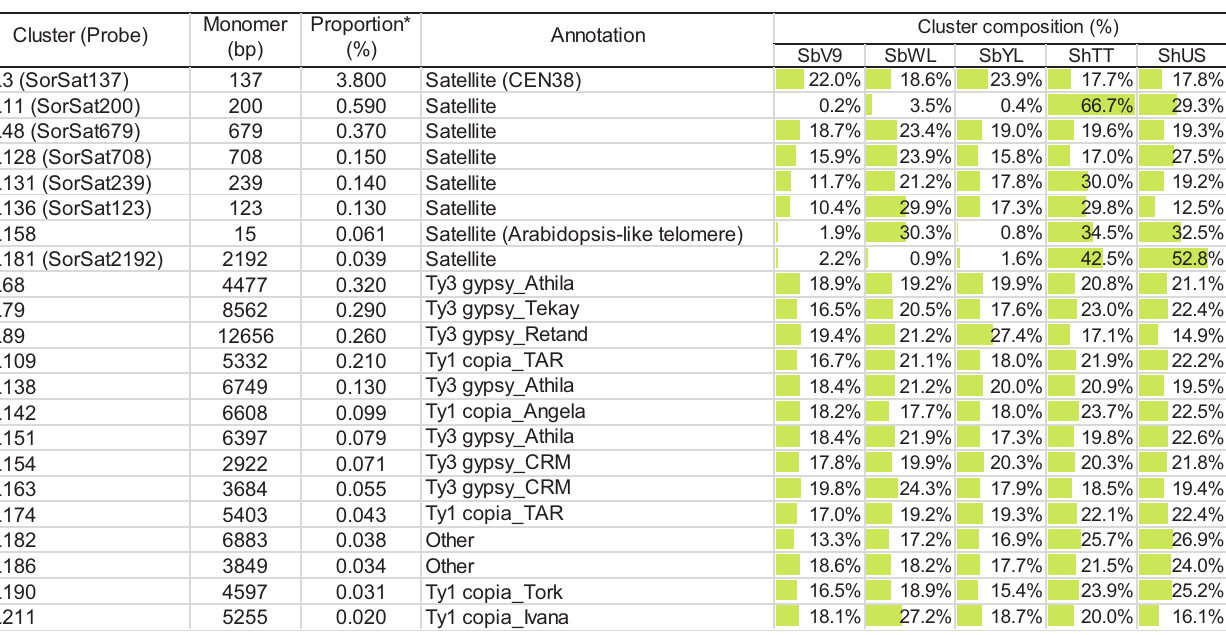
FIGURE 1 | Comparative repeat analysis of the five Sorghum accessions. The top 141 clusters with a proportion greater than 0.1% of the analyzed reads are shown. The bar plot (top) shows the size (number of reads) of individual clusters. The color of rectangles represents the final annotation of each cluster, and the size is in proportion to the abundance of the repeat in each genome. The species and clusters are ordered using hierarchical clustering based on the correlation of quantities. The position of the satellite-type cluster CL11 (one of the two repeats with an enriched abundance in S. halepense ) is marked with an asterisk. TABLE 3 | Cluster composition of the satellite and LTR repeats in the five Sorghum